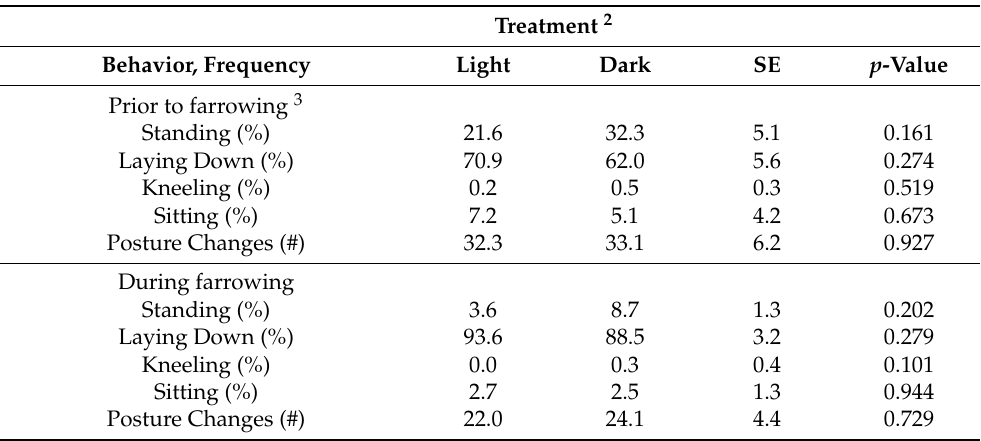
Table 4. Effect of light treatment on sow behavior before and during farrowing 1